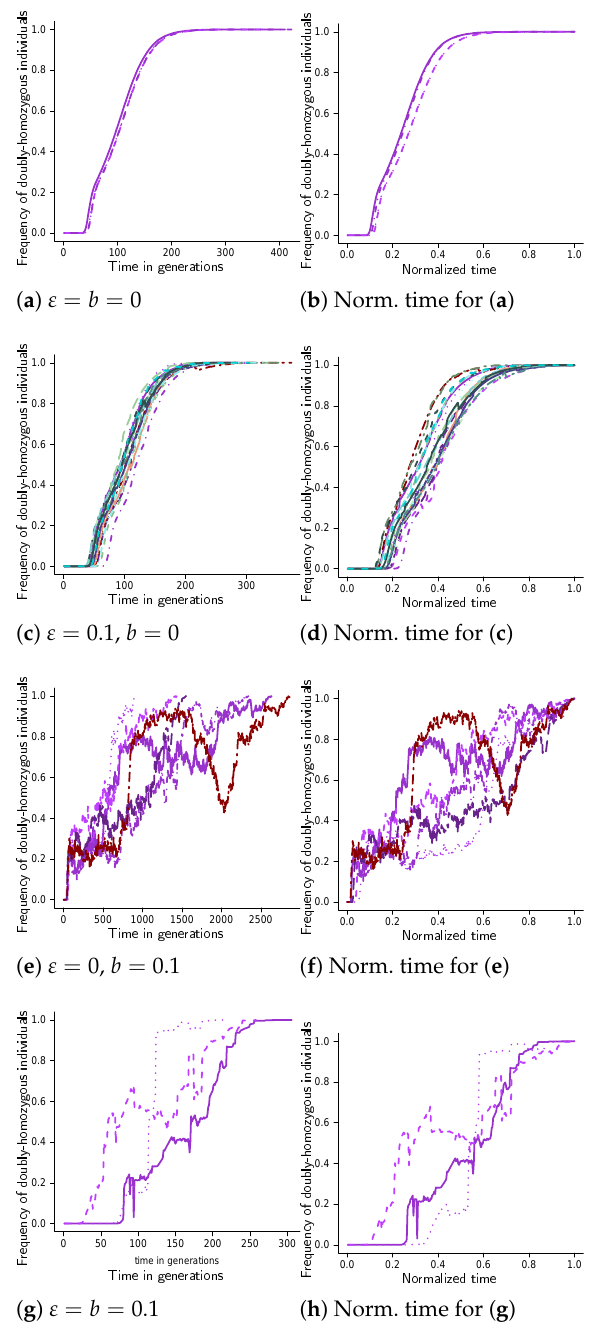
Figure 1. Fixation at two sites with weight function as in Equation (9). Examples of excursion to fixation at two sites ( L = 2 ) with weight as given by Equation (8) with weight function as given by Equation (9) for carrying capacity C = 10 6 , cutoff u ( N ) = C (see Equation (5)), probability of recombination r = 0.25 between adjacent sites, α 1 = 0.75, α 2 = 3, with ε (see Equation (7)) and b (the probability of a bottleneck in a given generation) as shown, strength of selection s = 0.1, bottleneck B = 10 3 throughout, number of replicates 10 2 except ten for ( a ). Each trajectory traces, as a function of time, the number of diploid individuals homozygous for the fit type at all sites relative to the population size (the number of diploid individuals). The panels on the right ( b , d , f , h ) show the corresponding excursions from the left panels ( a , c , e , g ) where the time to fixation for each excursion is normalized by the time to fixation for the excursion. The scale of the abscissa (time axis) may vary between panels; in each panel, the trajectories were all obtained under identical